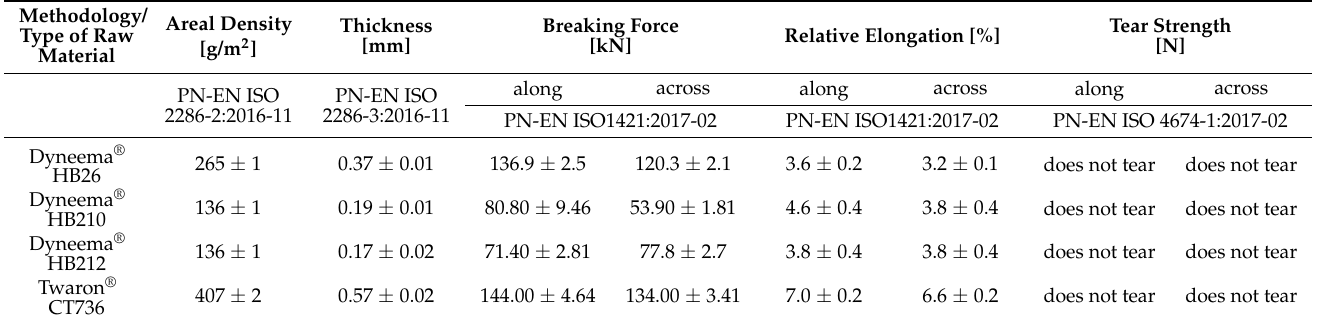
Table 1. Properties of the soft fibrous composite consisting of the UHMWPE fibers.